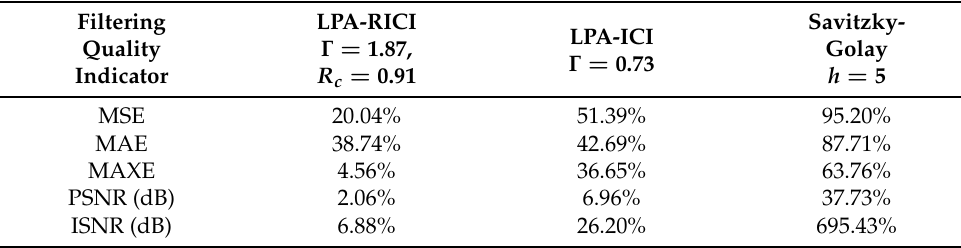
Table 40. Sing signal (SNR = 7 dB)—Filtering quality improvement of the RBF-RICI-based filtering over other tested